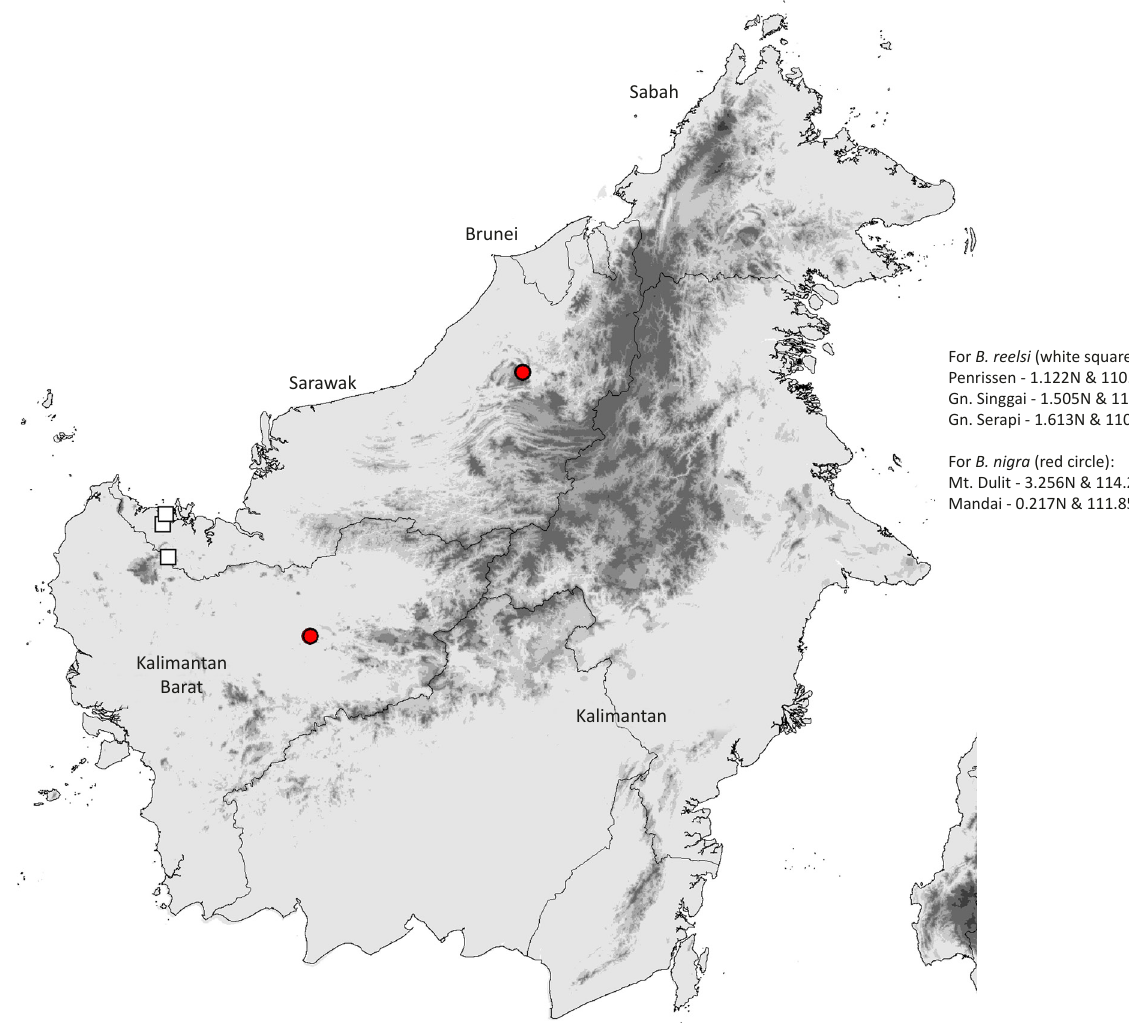
Image 11. Distributions of Bornargiolestes species. Red circle - B. nigra ; white square - B. reelsi . Coordinates given to three decimal places. Location names (south to north): Mandai - Sungai Mandai Hills; Penrissen - Gunung Penrissen; Singgai - Gunung Singgai; Serapi - Gunung Serapi in Kubah National Park; Dulit - Mount